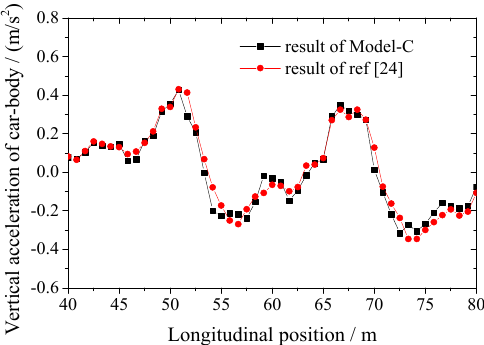
Figure 9. Comparison between the results of Model-C and [24]. Table 3. Comparison between measured data and simulation.